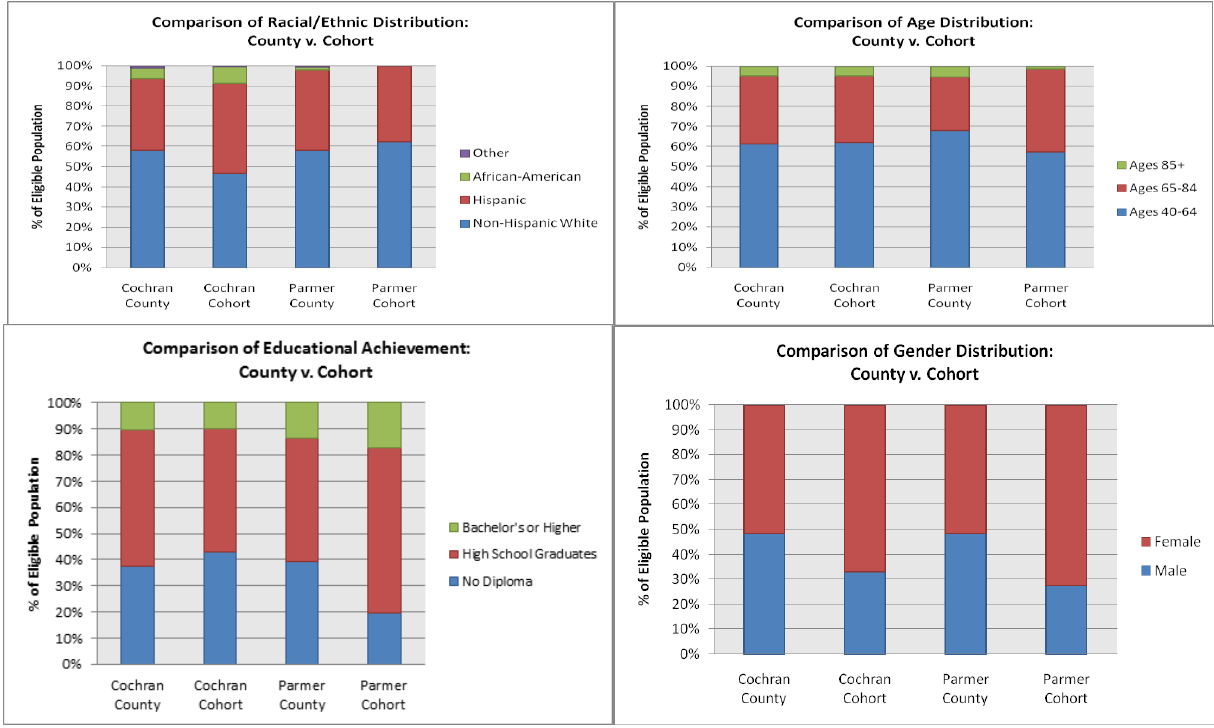
Figure 1. Demographic comparison of enrolled participants (Cochran Cohort & Parmer Cohort) versus all eligible individuals in each county (Cochran County & Parmer County) for race/ethnicity, age, education, and